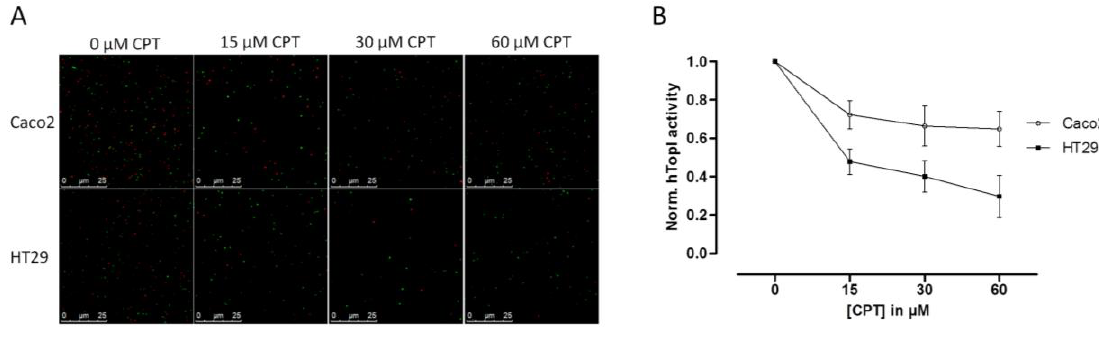
Figure 3. ( A ) REEAD based detection of hTopI activity in whole cell extract of Caco2 and HT29 in the presence of CPT. One example (Raw data) randomly picked out